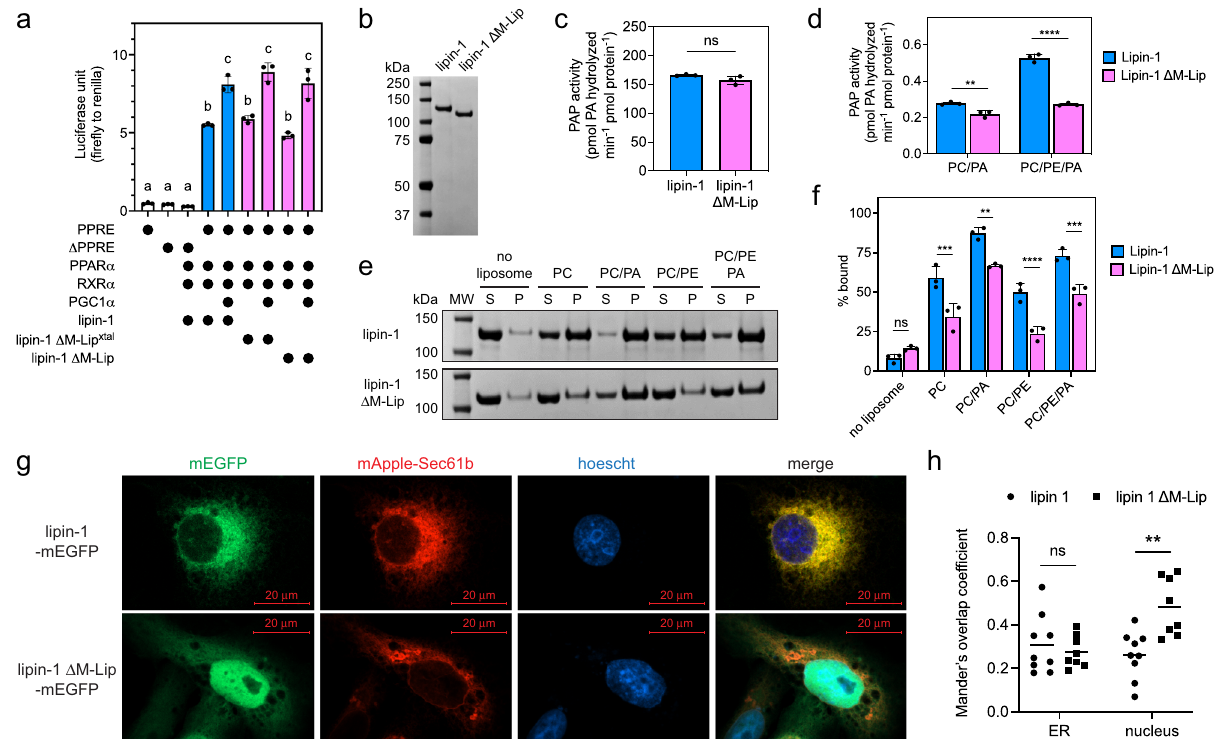
Fig. 3 The M-Lip domain reduces lipin 1 membrane association and PAP activity. a Deletion of the M-Lip or M-Lip xtal domain does not affect lipin 1 transcriptional co-activation. HEK293 cells were co-transfected with lipin 1 or lipin 1 M-Lip domain deletion constructs with the transcription factors PPAR α and RXR α , and the transcriptional co-activator PGC1 α . Transcriptional co-activation was quantitated by measuring fi re fl y luciferase activity, which is